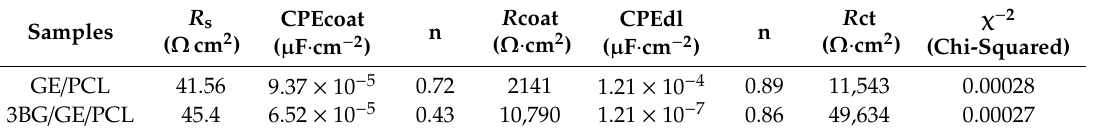
Table 4. The circuit parameters of EIS results of PCL-10 wt.% Gelatin-1,3 and 5% Bioglass composite calculated using z-view software (version 3.1) in a PBS solution at room